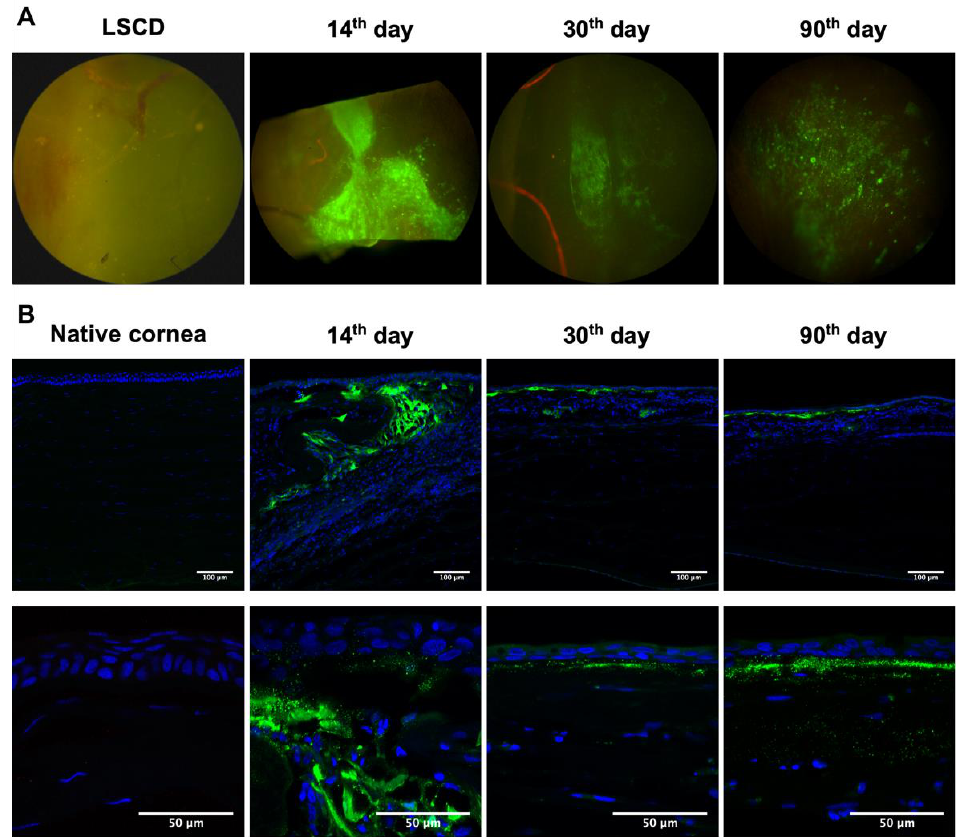
Figure 4. Localization of EGFP signal in rabbit cornea (peripheral area presented) at different times after transplantation of L-MSC-EGFP cells. ( A ) View from the top; corneal sectors with limbal stem cell deficiency (LSCD) and on the 14th, 30th, and 90th days after transplantation. Magnification × 50. ( B ) Localization of EGFP signal within rabbit corneal sections at different time points after L-MSCs- EGFP transplantation. Laser scanning confocal microscopy. Green—GFP channel; blue—DAPI. Scale bars: 100 μm and 50 μm.